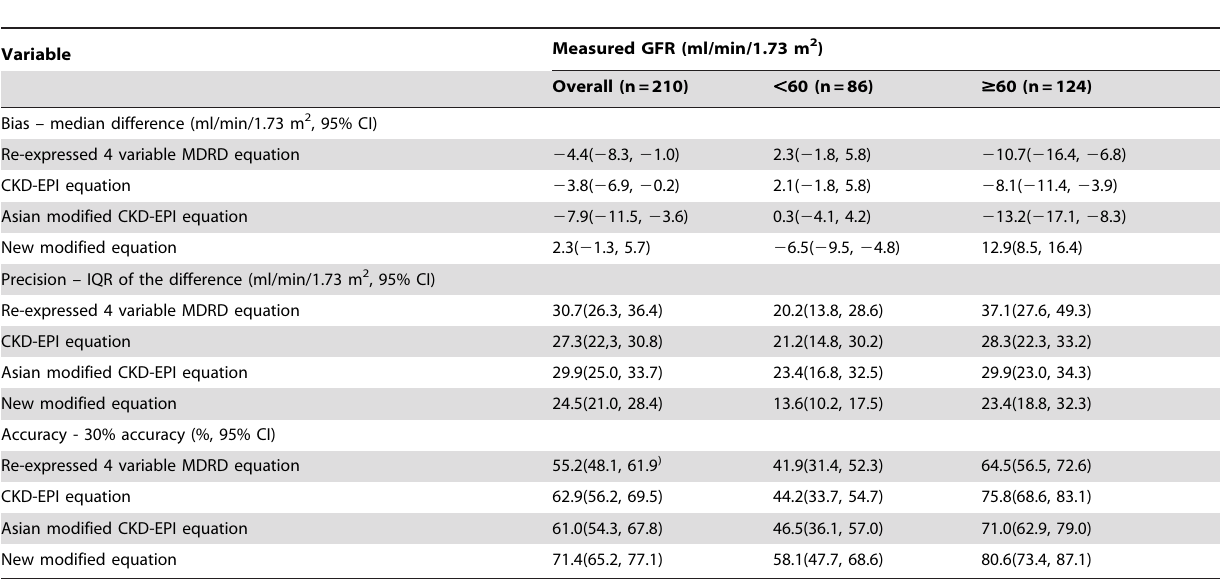
Table 5. Performance of bias, precision and accuracy between measured GFR and estimated GFR in the validation data set.